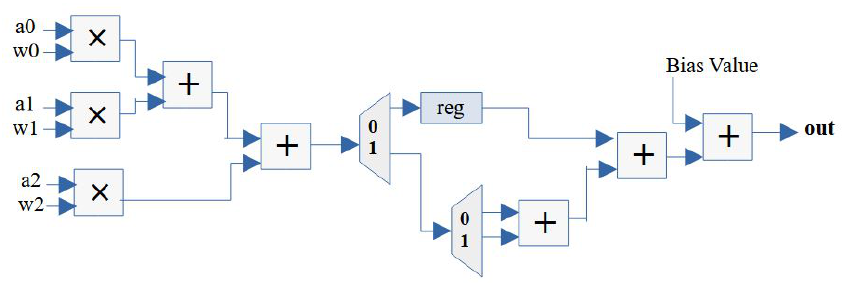
Figure 8. Iterative design structure of a convolutional layer neuron.